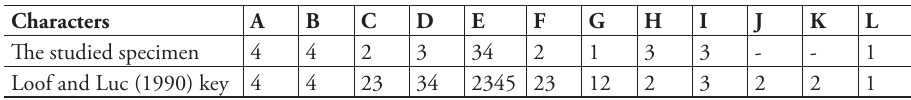
Table 1. Alpha-numeric codes of the polytomous identification key for Xiphinema species by Loof and Luc (1990) of Xiphinema elongatum and the studied specimens.